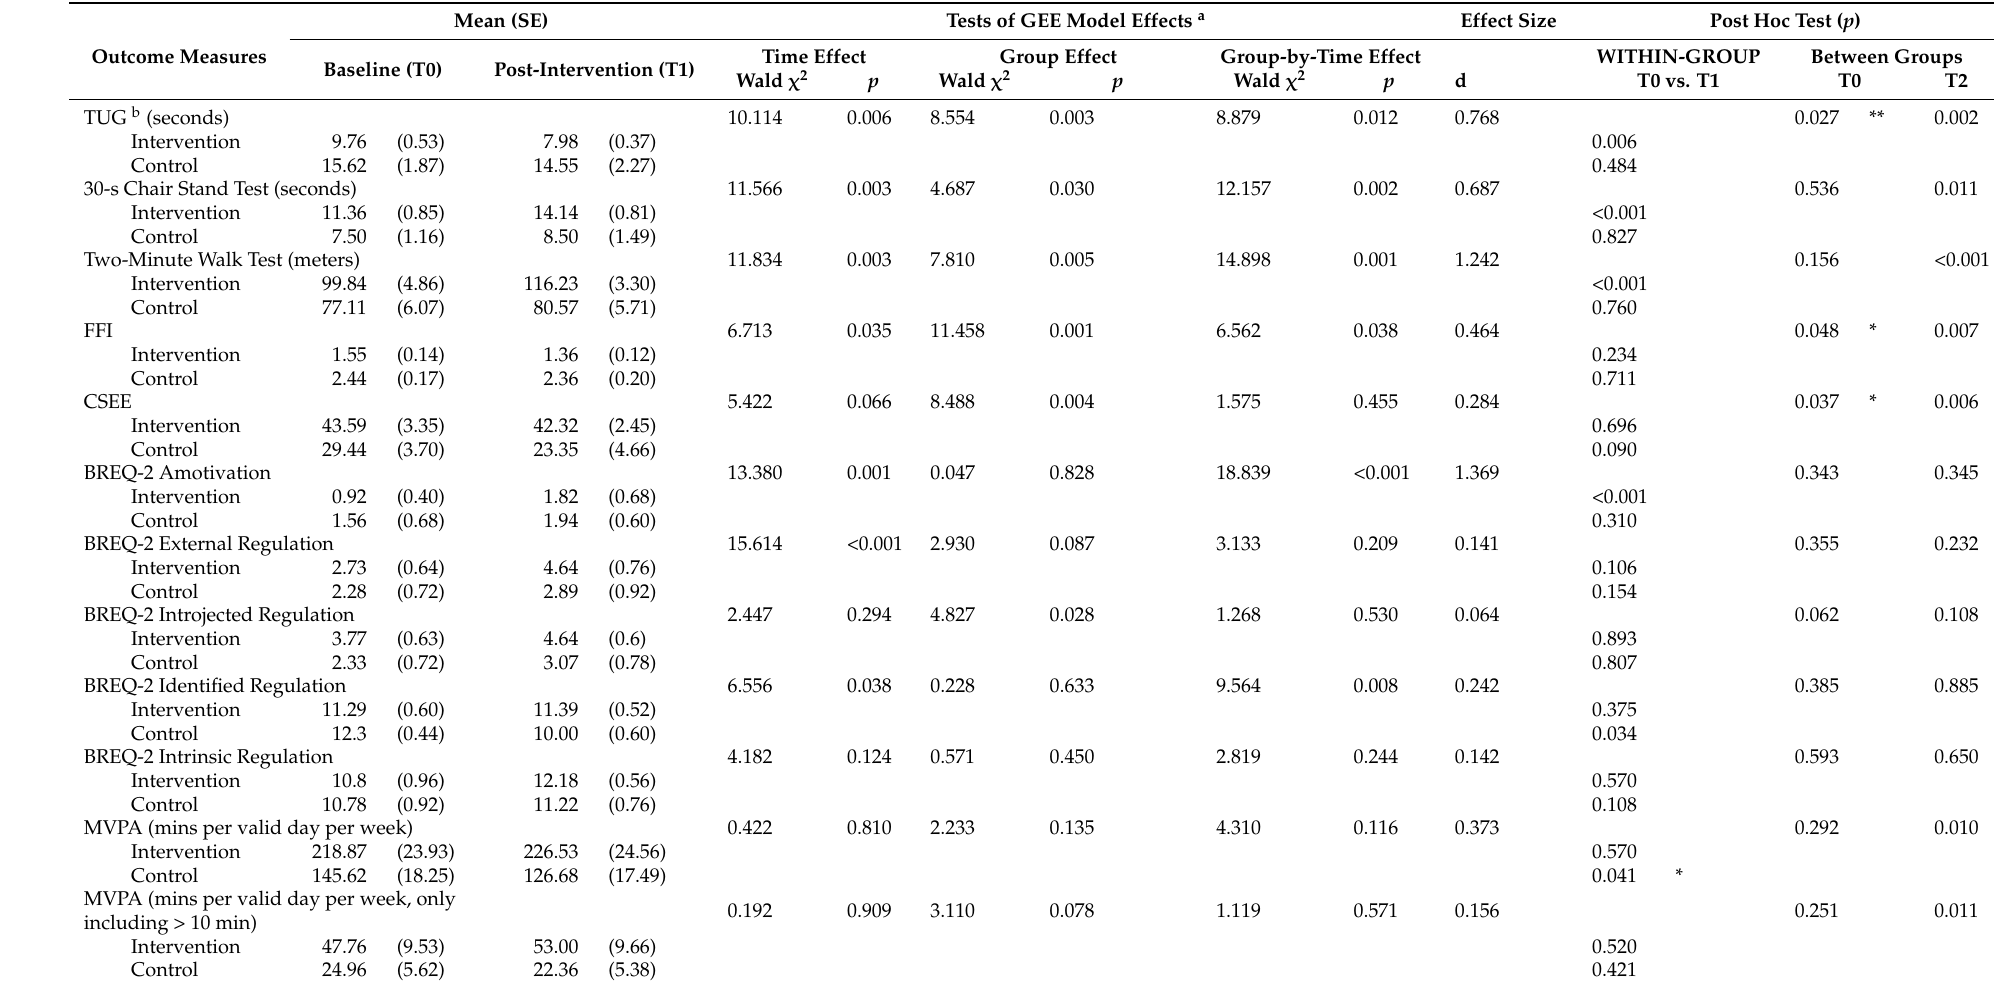
Table 5. Effectiveness of the intervention between